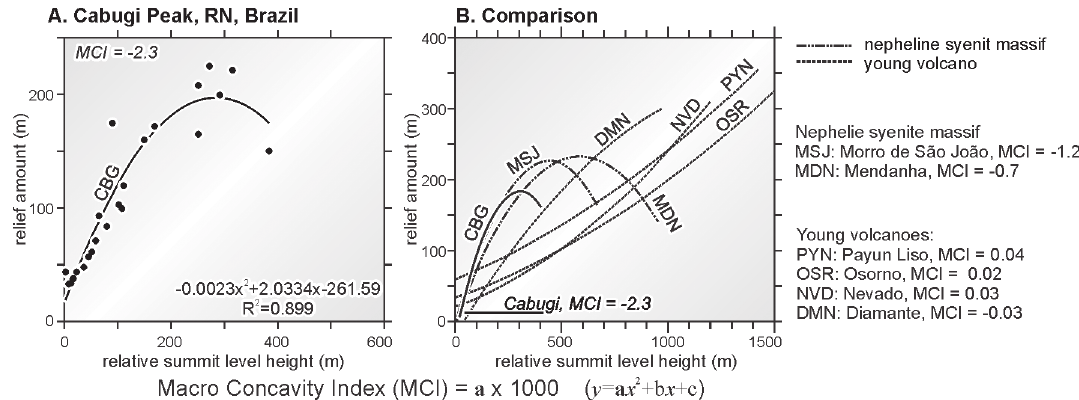
Figure 7 - The diagram for the calculation of MCI (Macro Concavity Index) using second order polynomial regression , after Motoki et al. (2012c, 2014). CBG - Cabugi Peak (Rio Grande do Norte, Brazil); MSJ - Morro de São João massif; MDN - Mendanha alkaline massif (Rio de Janeiro, Brazil); DMN - Cerro de Diamante volcano, NVD - Nevado volcano; PYN - Payún Liso volcano (Mendoza, Argentina), OSR - Osorno volcano (Chile).